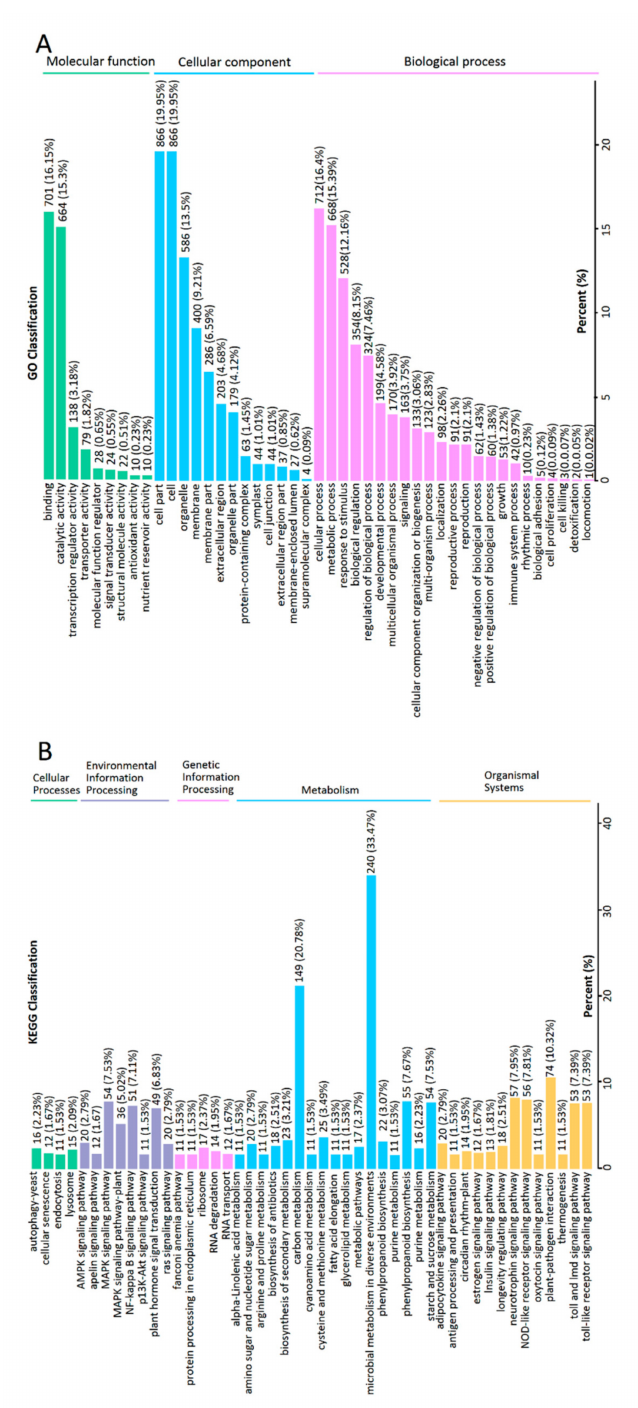
Figure 4. The classification column of GO and KEGG from the DEGs between the NM and M growth for six months. ( A ) GO classification of DEGs. The x-axis represents the secondary GO item. The y-axis represents the proportion of the DEGs in the total number of DEGs. The labels above the columns is the number and proportion of DEGs of this GO item. ( B ) KEGG classification of DEGs. The x-axis represents the name of KEGG pathway. The y-axis represents the proportion of genes annotated to the pathway in the total of annotated genes. The labels above the columns represent the classification of KEGG